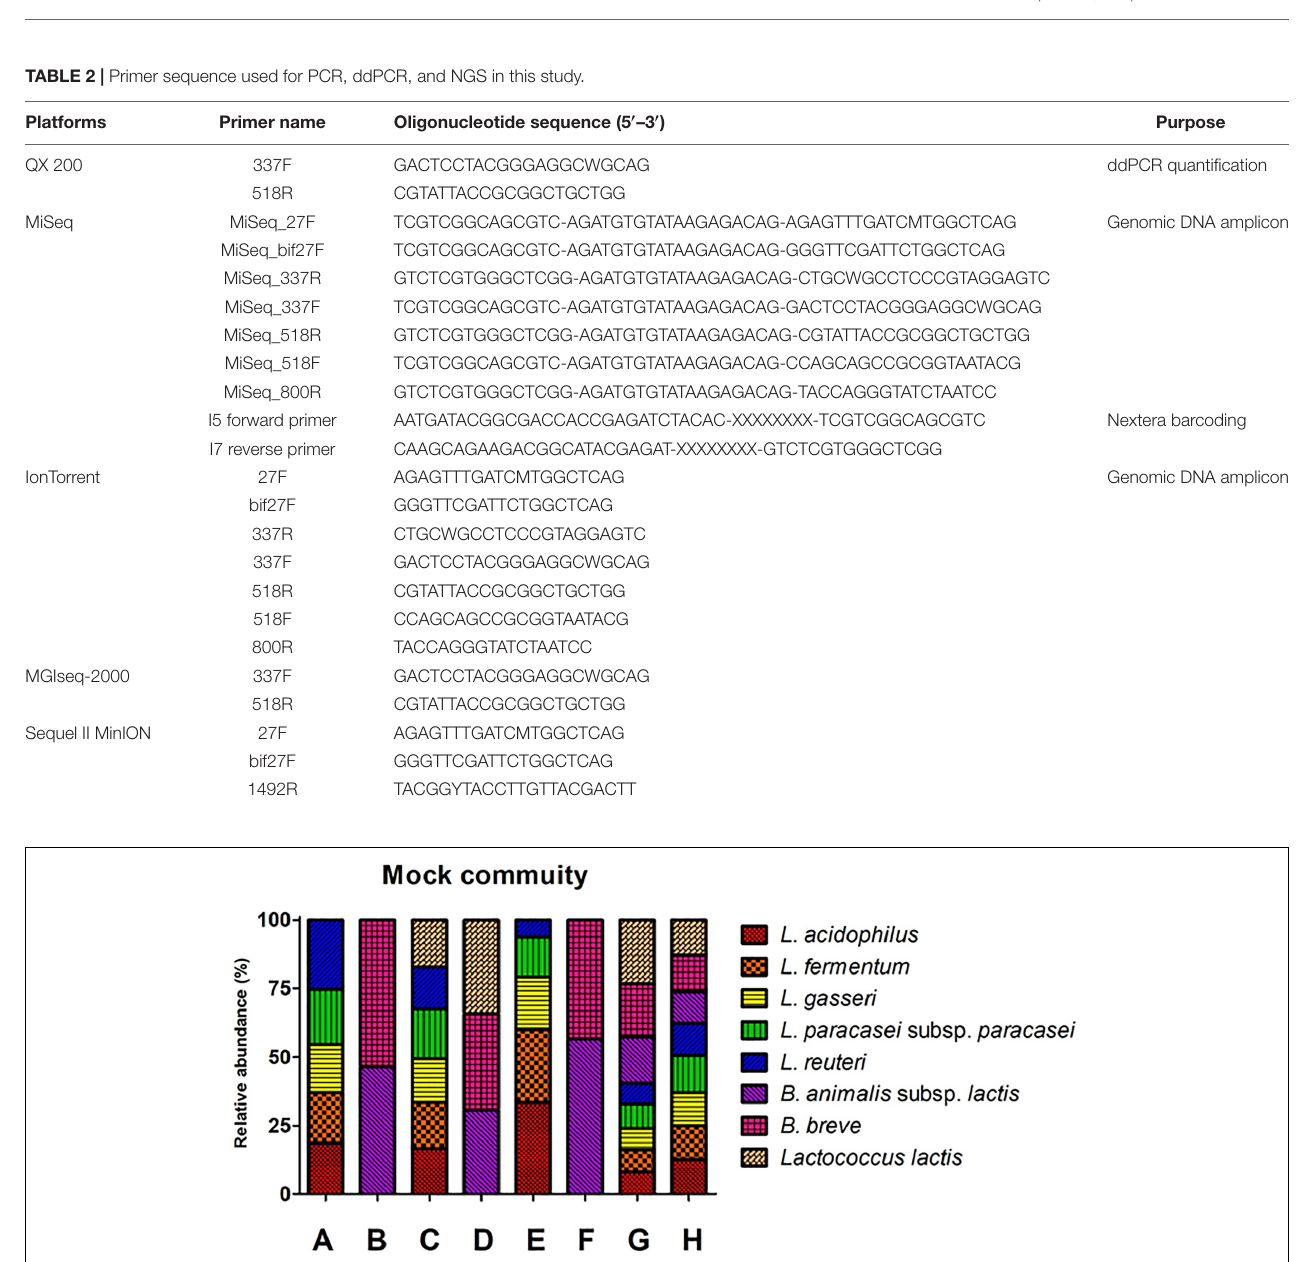
United States). The normalized sequencing libraries were pooled and sequencing was carried out at ChunLab, Inc., with the